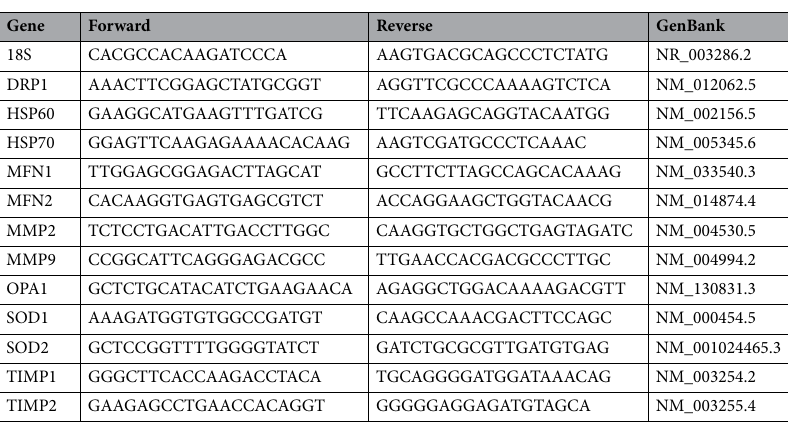
Table 1. Primer sequences of human genes analyzed via RT-PCR.